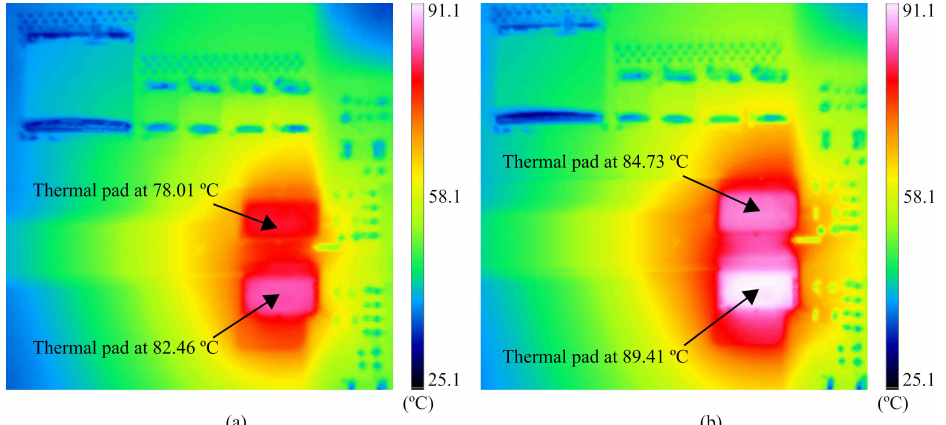
Figure 19. Thermal images of the GaN-based converter using different deadtimes: ( a ) 40 ns and ( b ) 100